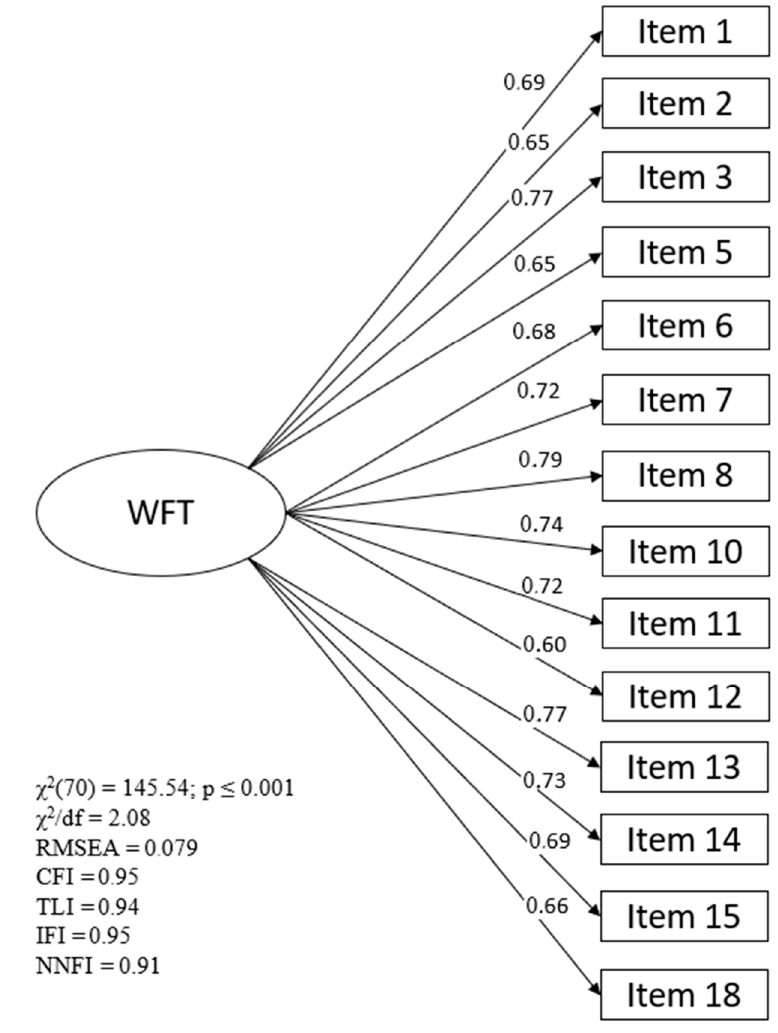
Figure 1. Confirmatory Factor Analysis results.